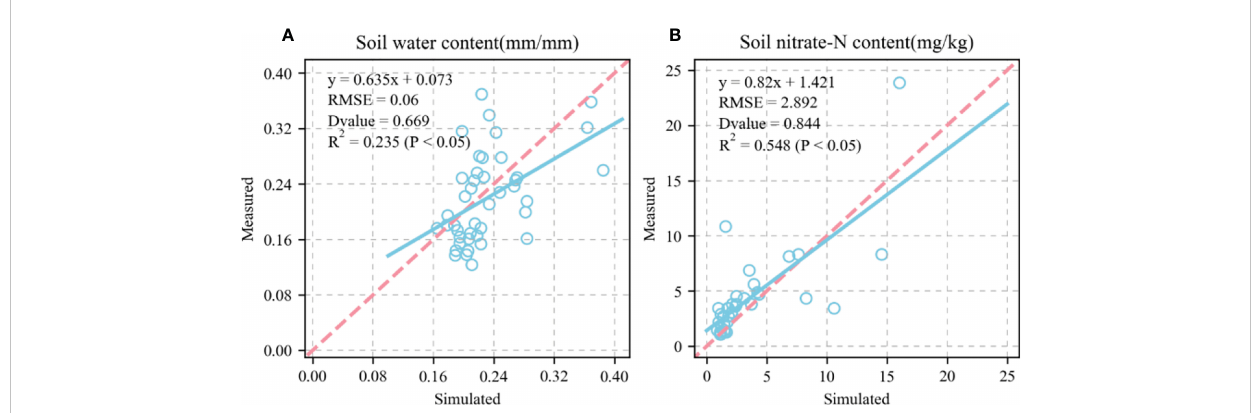
FIGURE 8 Comparison between simulated and measured soil water content and soil nitrate content (1:1, dashed line). (A) , soil water content; (B) , soil nitrate content. Blue circle represents simulated and measured values. Straight line represents regression line of fi tting equation between measured and simulated value. RMSE is root mean square error which is used to measure deviation between observed and measured value. D-value is used to assess consistency between observed and measured value. R 2 is used to describe degree of fi tting of regression line to observed value. The closer is to 1, the better the fi tting. P < 0.05 means difference was highly signi fi cant.